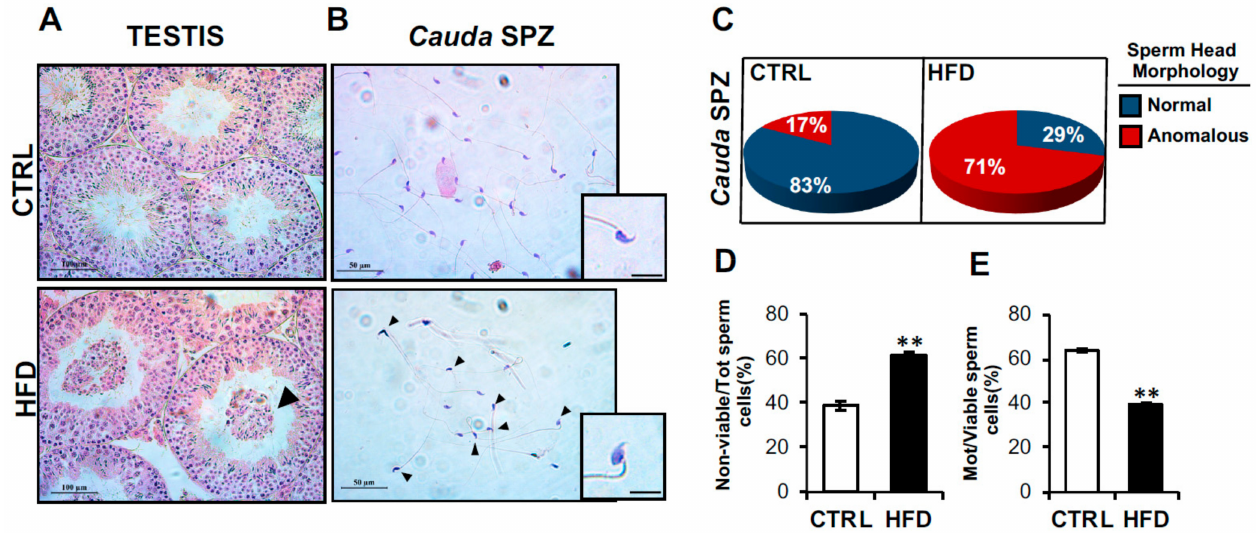
Figure 1. Characterization of HFD testis and sperm parameters. ( A , B ) H&E staining of testis ( A ) and cauda SPZ ( B ) collected from CTRL (n = 6) and HFD (n = 6) mice. ( A ) In testis sections, germ cell lumen infiltration was indicated by black arrowheads; scale bar: 100 µ m. ( B ) Anomalous sperm heads were indicated by black arrowheads; scale bar: 50 µ m; scale bar inset: 10 µ m. ( C ) Percentage of anomalous sperm heads in CTRL and HFD cauda SPZ; data were reported as the percentage of anomalous sperm heads/total SPZ. Sperm viability ( D ) and motility ( E ) assay in CTRL and HFD cauda SPZ; data were expressed as the percentage of nonviable/total SPZ and motile/live SPZ, respectively, and reported as mean ± SEM; ** p <